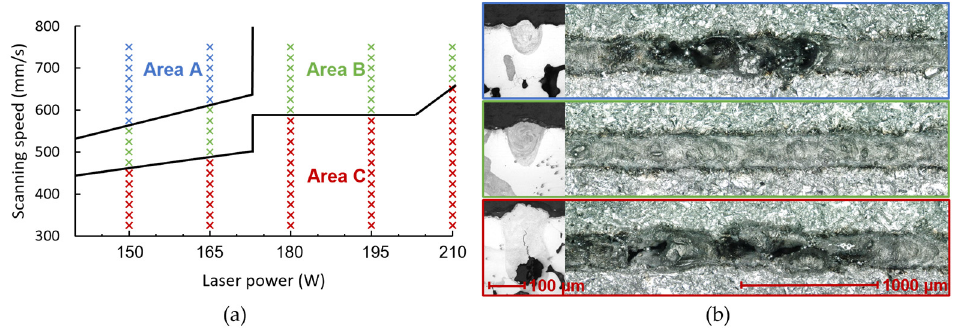
Figure 4. ( a ) Map of process parameters for single-track test with defined areas and ( b ) representative single track for a specific area (metallographic image and 3D digital microscope image).